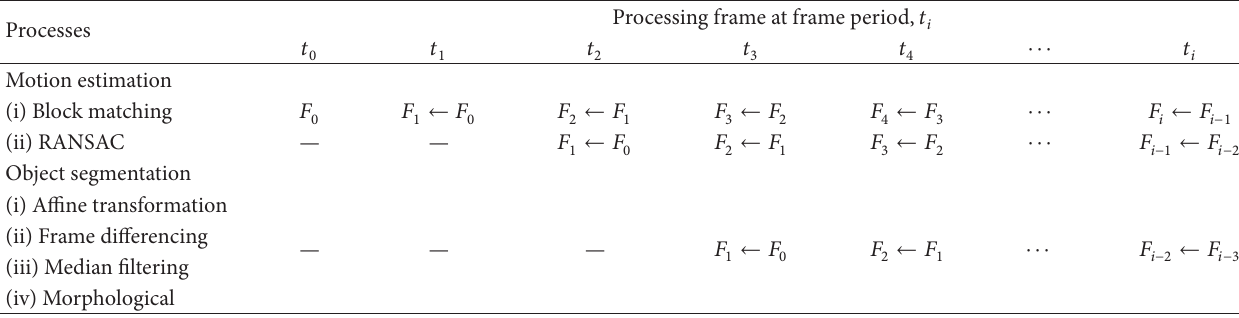
Table 2: Pipeline scheduling for processing subsequent